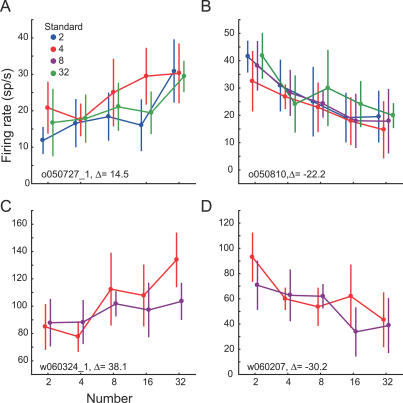
Single LIP Neurons Respond in a Graded Fashion to the Total Number of Elements in the Response FieldFiring rate for each number (mean ± standard error [SE]) in the 400-ms epoch beginning 50 ms after stimulus onset, plotted for each standard block tested (line color). The change in firing rate (Δ) over the range of numerosities tested was estimated by linear regression with the logarithm of stimulus number (all p < 0.01; Materials and Methods, Equation 2). Numerical sensitivity did not depend on standard block (ANOVA, number × standard: [A] p = 0.59, [B] p = 0.99, [C] p = 0.10, and [D] p = 0.17). Neurons in (A) and (C) increased firing with larger numerosities, whereas those in (B) and (D) had larger responses for smaller numerosities.